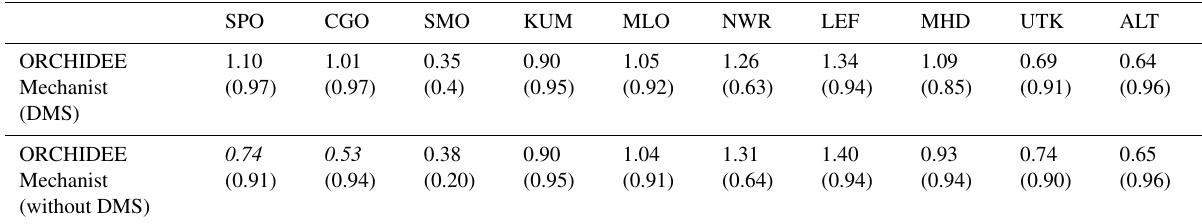
Table D2. Normalised standard deviations (NSDs) of the simulated concentrations by the observed concentrations. Within brackets are the Pearson correlation coefficients ( R ) between simulated and observed COS concentrations for the mechanistic approach including the DMS or not, calculated between 2004 and 2009 at 10 NOAA